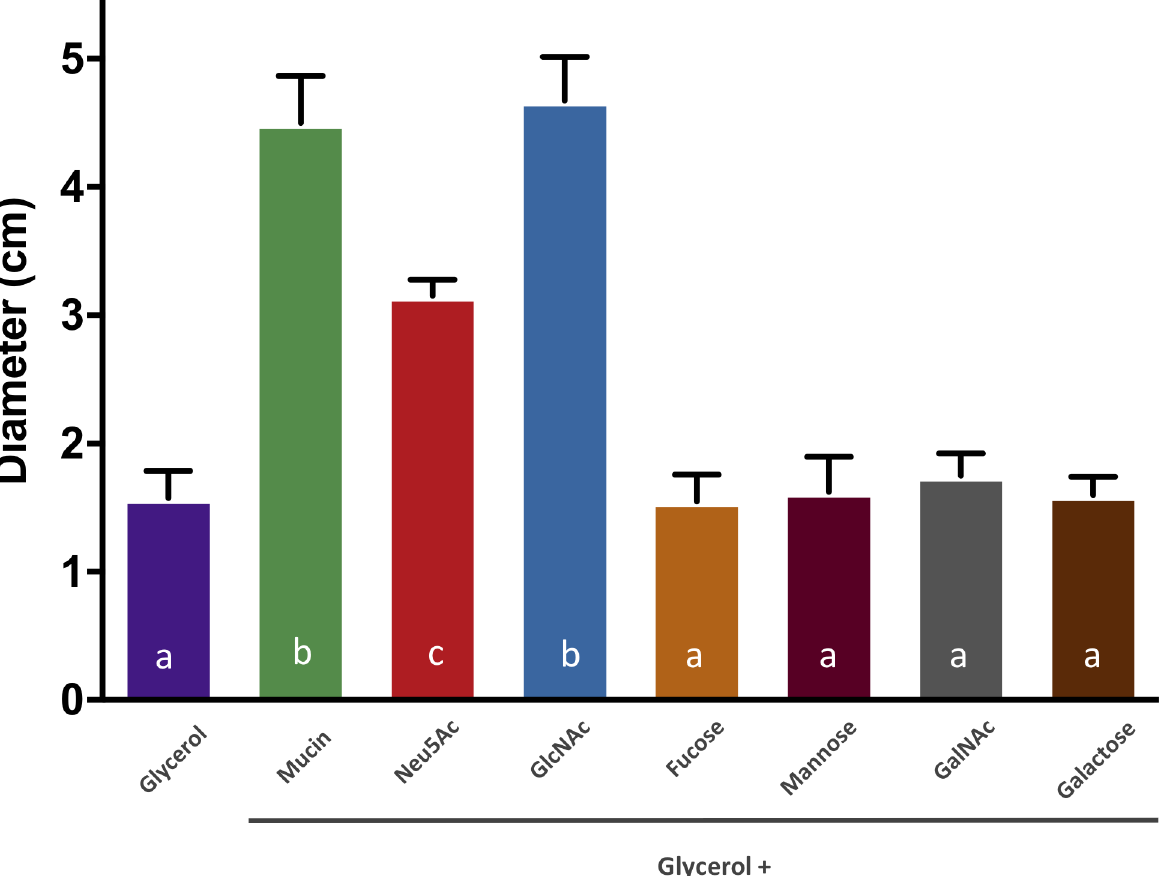
Fig 1. Motility of V . cholerae in the presence of mucus components. Motility assays of V . cholerae N16961 in glycerol supplemented with mucin and oligosaccharides found in mucin. The y axis denotes the diameter of the motility zone in cm and the x axis indicates the carbon source added to the motility plates. Columns represent the mean of four independent experiments and error bars the standard deviation. Statistical comparisons used one-way ANOVA followed by Tukey’s HSD test; bars with the letter a are not significantly different at alpha = 0.05 from one another but are different from b and c at P < 0.0001. Furthermore, b and c are also significantly different from each other with a P < 0.0001.